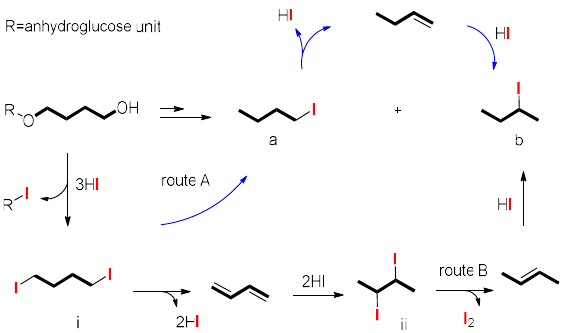
Figure 4. Proposed mechanism of iodobutane generation from δ-HBS. (R=anhydroglucose unit).